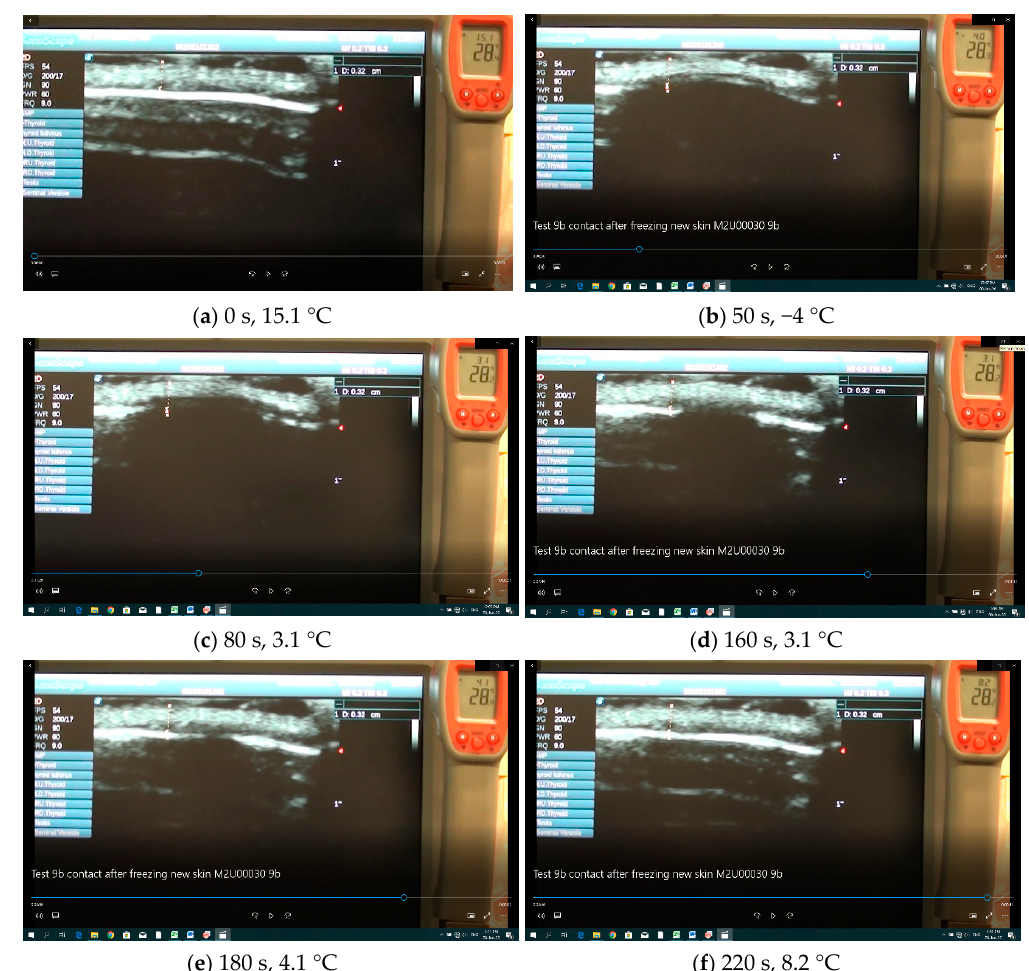
Figure 10. ( a – f ) Distinct sequential frames of the video taken during thawing.